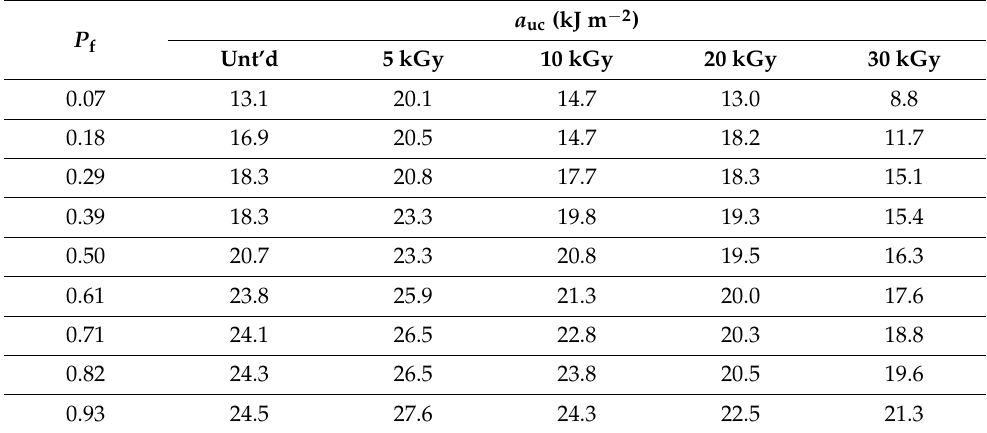
Table 1. Charpy impact strength, a uc (kJ m − 2 ) and P f for individual specimens from the data in Figure 5.